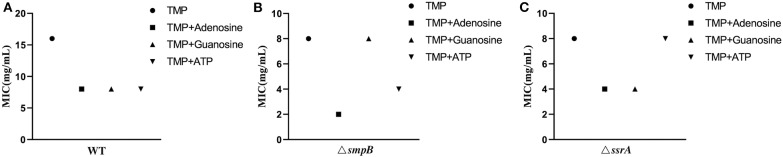
MIC value of trimethoprim under conditions of adenosine, guanosine and adenosine triphosphate. (A) MIC value of wild type with 1 mM adenosine, 1 mM guanosine, and 10 mM ATP in M9 medium. (B) MIC of ΔsmpB with 1 mM adenosine, 1 mM guanosine, and 10 mM ATP in M9 medium. (C) MIC of ΔssrA with 1 mM adenosine, 1 mM guanosine, and 10 mM ATP in M9 medium.